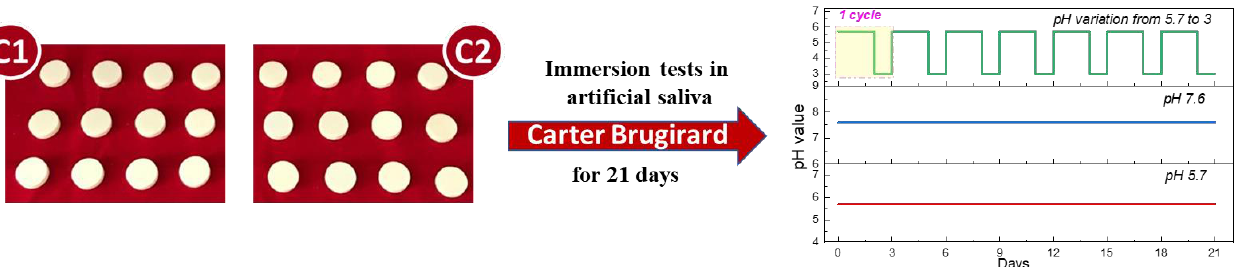
Figure 1. Images of the experimental samples (C1 — Trinia TM and C2 — TriLor) and pH value of the artificial saliva. Table 2. Chemical composition of Carter Brugirard artificial